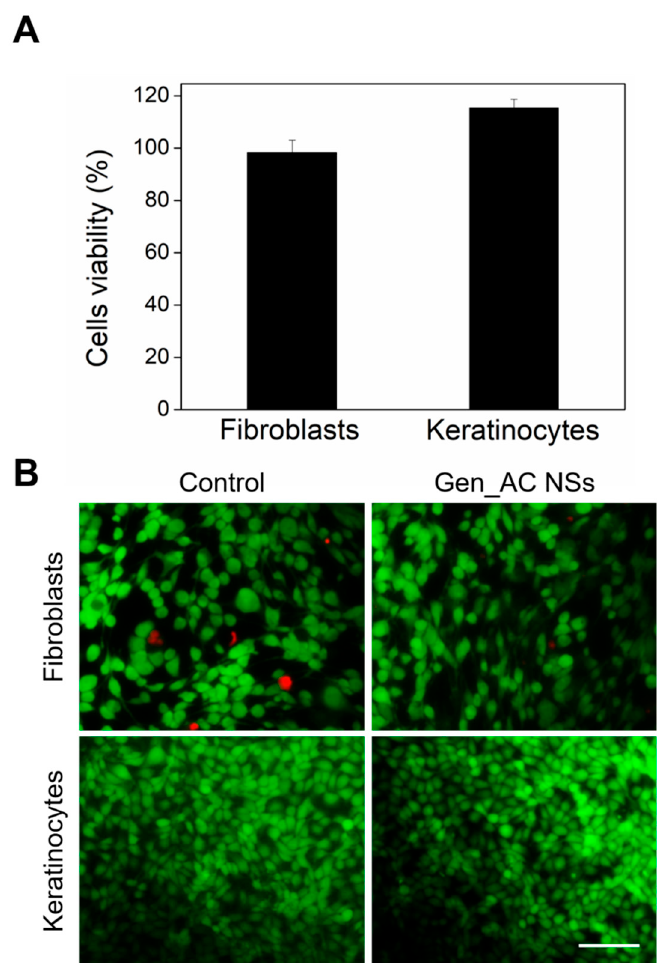
Figure 6. ( A ) Relative viability of HaCaT and BJ-5ta cell lines after 24 h exposure to bactericidal concentrations (0.25 × 10 13 NSs/mL) of GeN_AC NSs determined by AlamarBlue™ assay; ( B ) Fluorescent microscopy images of HaCaT and BJ-5ta cell lines after 24 h of exposure to GeN_AC NSs. The green (live cells) and red (dead cells) fluorescence images are overlaid. Scale bar corresponds to 100 μ m.